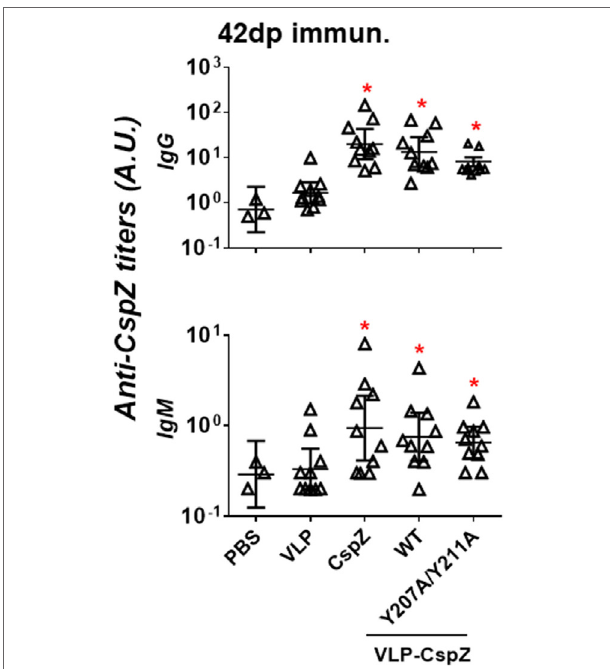
FigUre 2 | Immunization of CspZ, VLP-CspZ, and VLP-CspZ-Y207A/Y211A triggered undistinguishable antibody response against CspZ. Ten C3H/HeN mice were inoculated with PBS (“PBS”), virus-like particle (“VLP”), CspZ (“CspZ”), VLP-CspZ (“VLP-CspZ-WT”), or VLP-CspZ-Y207A/Y211A (“VLP-CspZ-Y207A/Y211A”), and the serum was obtained at 42 days post inoculation. The serum collected from three C3H/HeN mice at 42 days post inoculation of PBS was also included as negative control. The levels of IgG ( top panel ) and IgM ( bottom panel ) against CspZ were determined using quantitative ELISA as described in Section “Materials and Methods.” Data shown are the mean ± SD of three (PBS) or ten (all others) mice per group. Statistical significances ( p < 0.05) of differences in antibody titers relative to PBS-inoculated mice were determined using a one-way ANOVA test and are indicated